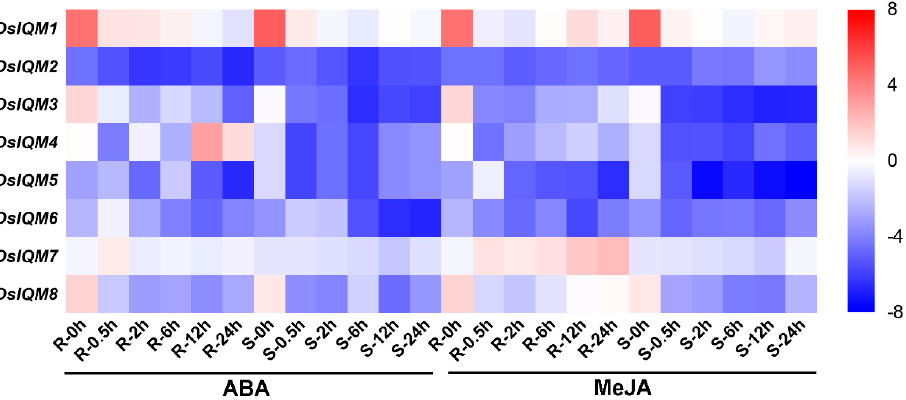
Figure 9. Heat map of the real-time quantitative PCR (qRT-PCR) analysis results of OsIQMs genes in leaves under ABA and MeJA treatment, with three biological and technical replicates. The scale representing the relative signal intensity values is shown